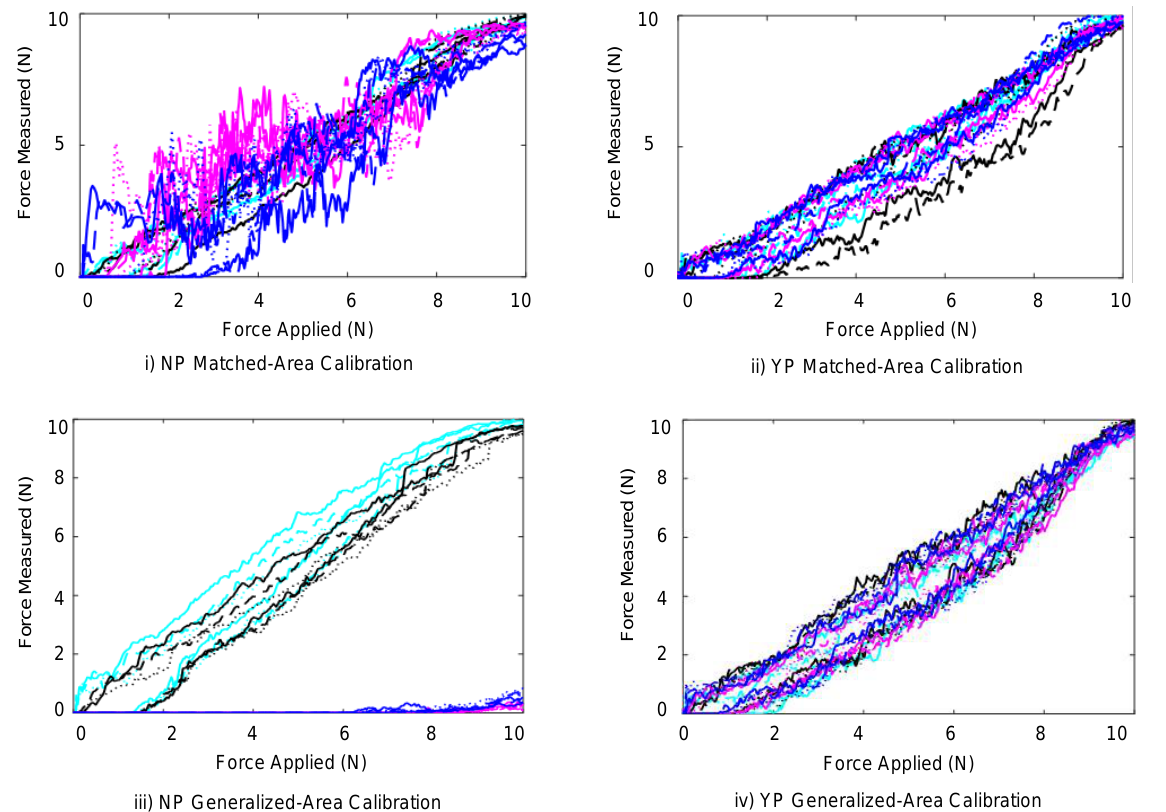
Figure 5: Force measured vs. force applied plots for two-second hysteresis tests for Sensitronics using MA and GA calibration methods.